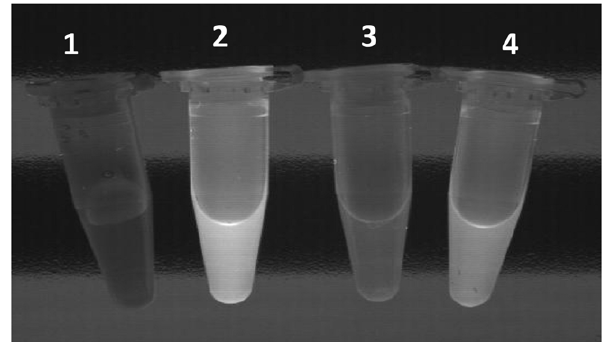
Figure 10. Fluorescence enhancement of 8-Anilino-1-naphtha- lene sulfonate (ANS) in the interaction with albumin. Different tube contents are: 1. Aqueous solution of ANS without protein; 2. ANS upon binding to normal albumin; 3. ANS upon binding to acrolein- treated albumin; 4. ANS upon binding to glycosilated albumin. When irradiated with UV light, intense fluorescence can be observed in tube containing ANS-normal albumin and a diminished fluorescence from the tubes with ANS-modified albumin; meanwhile no glow is observed in the tube with an aqueous solution of free ANS. The picture was taken directly on the UV transilluminator as described in Material and Method section.